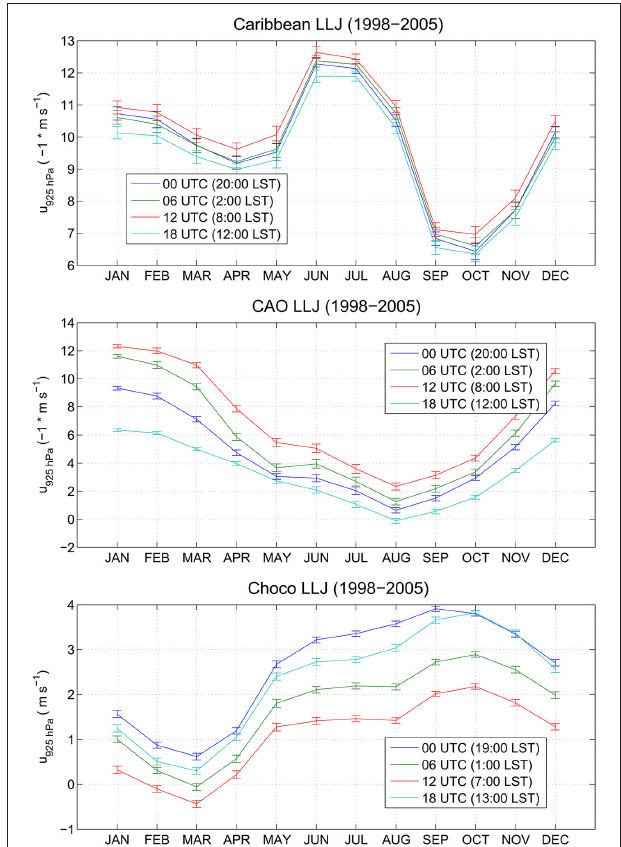
FIGURE 10 | Average diurnal cycle of the zonal winds at 925 hPa through the annual cycle for the period 1998–2005, at the core of the Caribbean (top) , CAO (middle) , and CHOCO (bottom) LLJs. Data source: ERA-Interim Reanalysis. Error bars denote the standard error of the